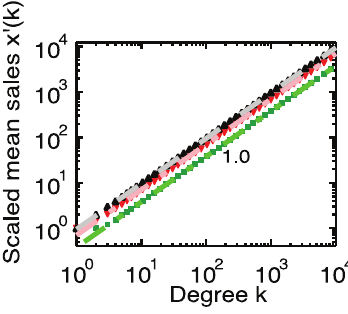
Figure 3. The mean of sales as a function of degree, x ( k ) , for Model-1. We plot the scaled values [ x ’ ( k ) ~ x ( k ) = x (1) ]. The black triangles indicate the network for c ~{ 0 : 7 , the red nablas for c ~ 0 : 0 and the green squares for c ~ 0 : 7 . The mean of sales as a function of degree, x ( k ) , for Model-1. From this figure, we can confirm that x ( k ) is proportional to k regardless of k nn ( k ) . These results agree with the approximation given by Eq. 11, namely, x ( k ) ! k .